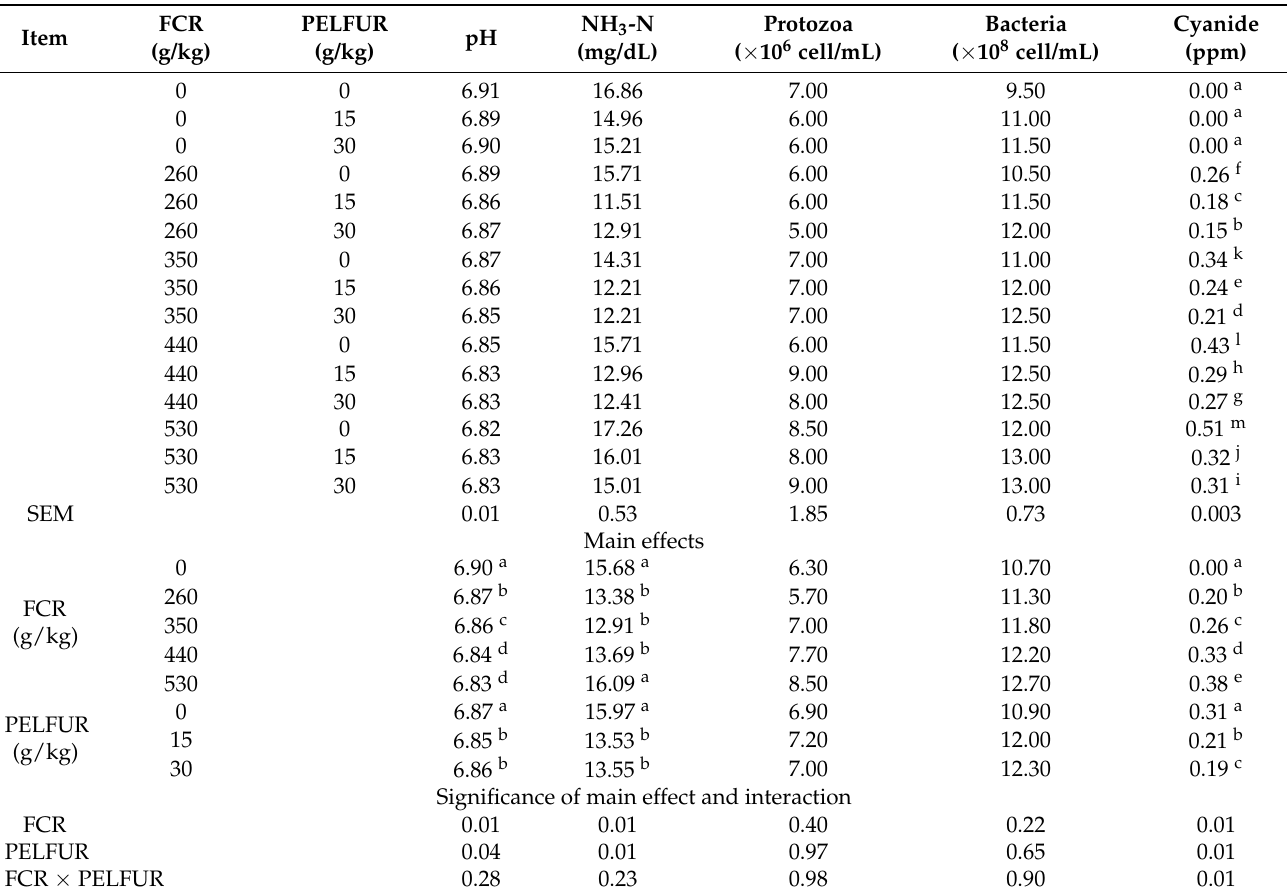
Table 3. Effect of fresh cassava root (FCR) with pellets containing high sulfur (PELFUR) on ruminal pH, ammonia-nitrogen (NH 3 -N) concentration, ruminal microbial population, and cyanide